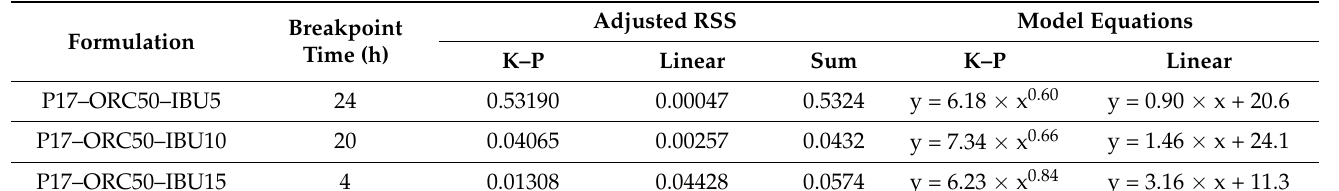
Table 9. A summary of segmented fit results.